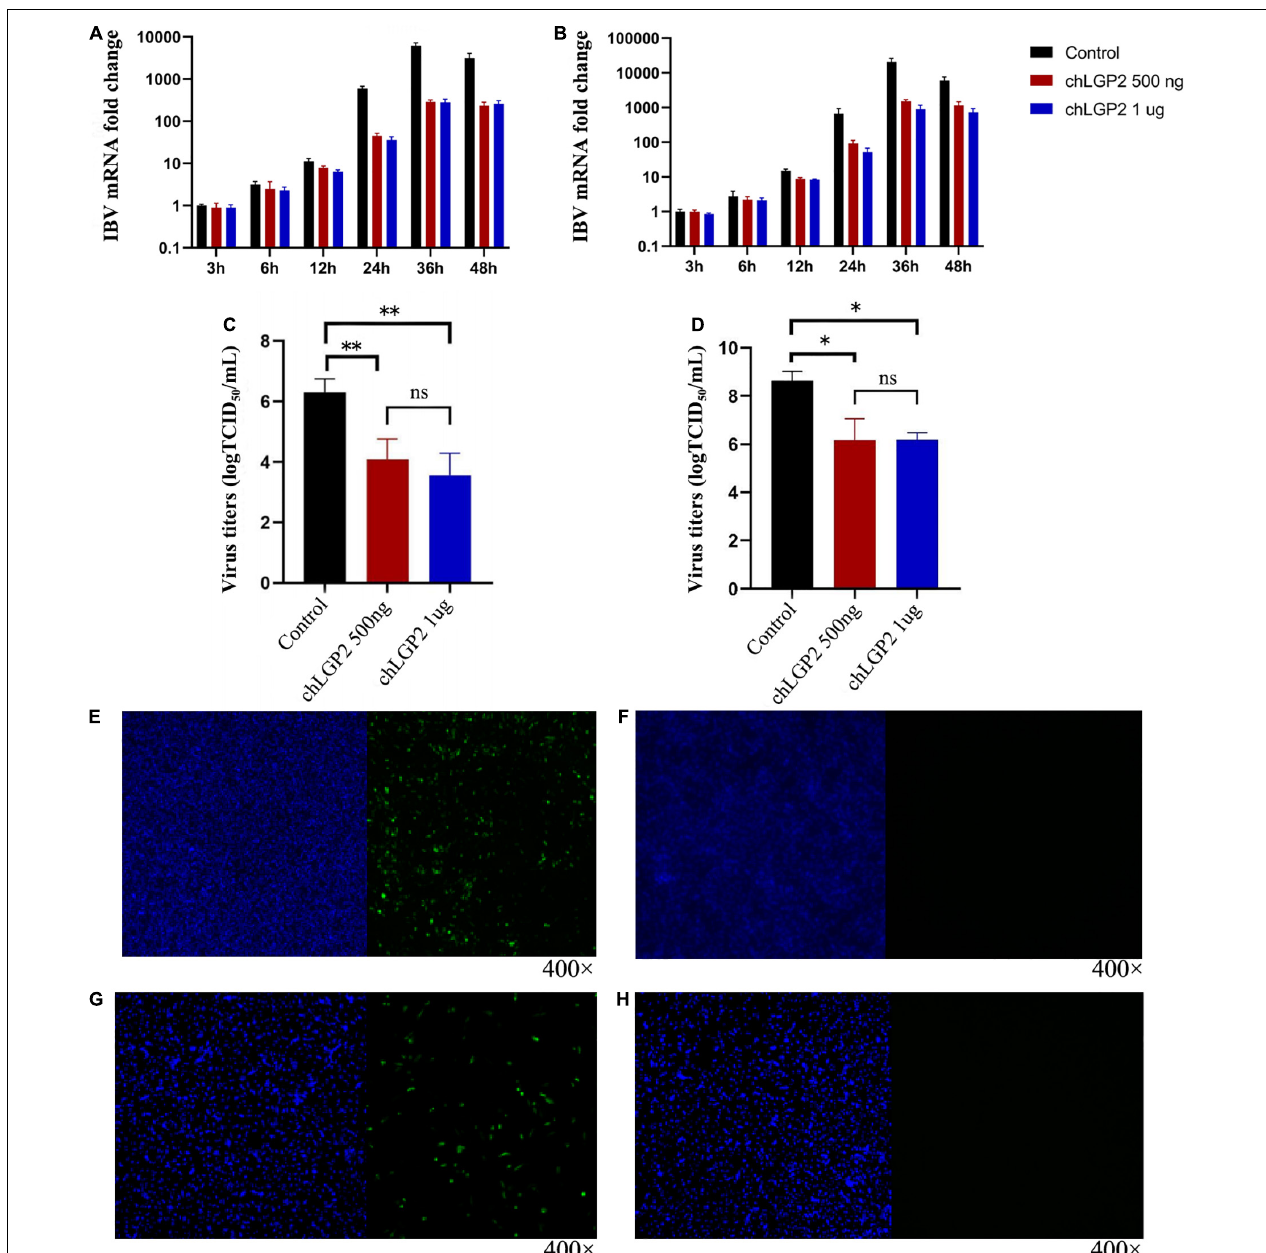
FIGURE 1 | Expression of chLGP2 in HD11 and DF-1 cells and effect on IBV Beaudette strain. chLGP2 overexpression significantly inhibited IBV Beaudette replication in (A) HD11 and (B) DF-1 cells. Virus titers (TCID 50 ) at 36 h post-infection in cell supernatant of (C) HD11 and (D) DF-1 cells. Expressions of (E) chLGP2 or (F) empty plasmid in HD11 cells. Expression of (G) chLGP2 and (H) empty plasmid in DF-1 cells. Blue fluorescence represents the nucleus, and green fluorescence represents the transfected chLGP2. Data are the mean values from three independent experiments, and error bars denote mean ± SDM. ∗ P < 0.05; ∗∗ P < 0.01; ns means not